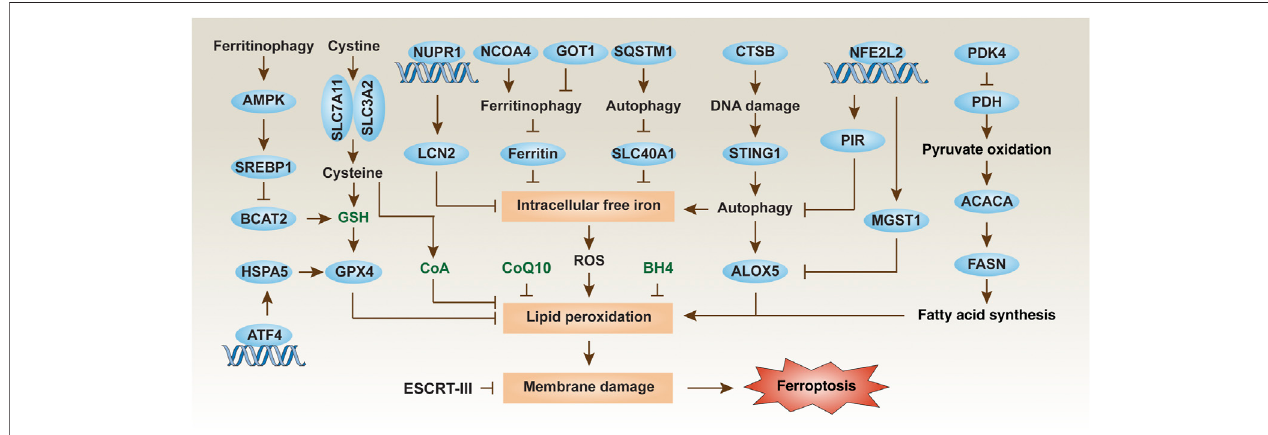
FIGURE 1 | Regulation mechanisms and signaling pathways of ferroptosis in PDAC cells. Ferroptosis is an iron-dependent cell death driven by lipid peroxidation and subsequent membrane damage. The level of ferroptosis in PDAC cells can be regulated in multiple ways, including through autophagic degradation, transcription factors, and metabolic